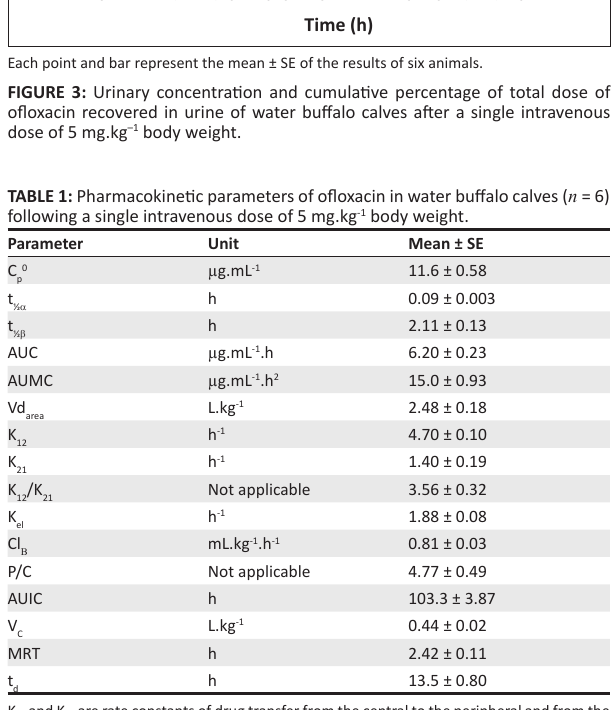
FIGURE 2: Semilogarithmic plot showing the plasma concentration–time profile of ofloxacin following a single intravenous injection of 5 mg.kg –1 body weight in water buffalo calves.